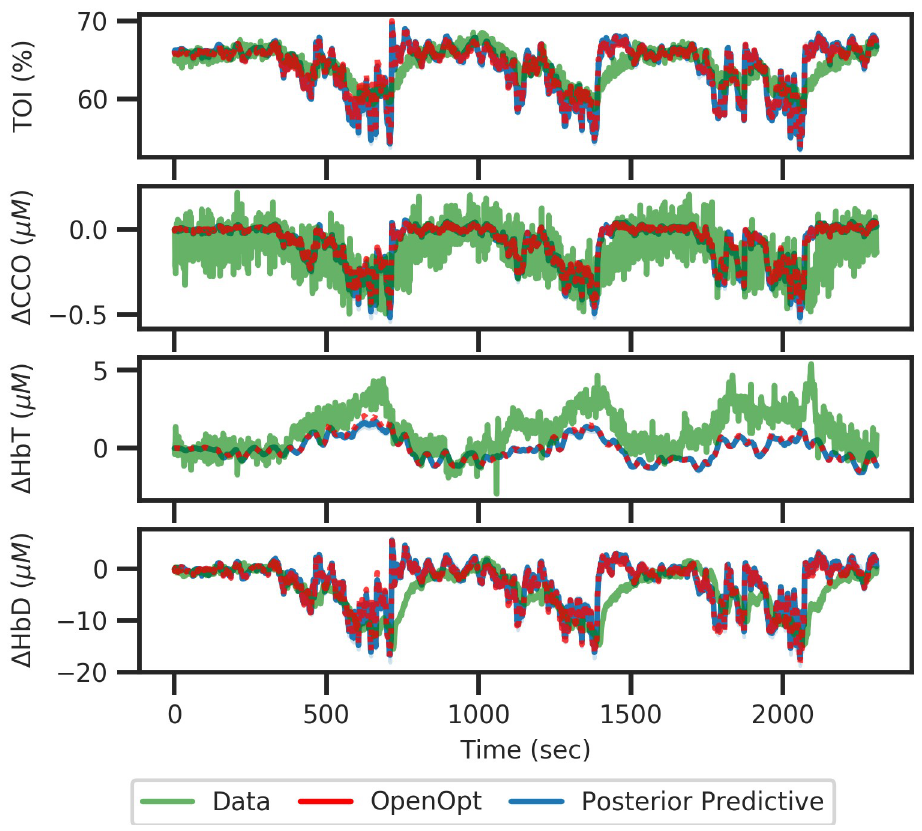
Fig 12. Predicted fits for the experimental data set. Fig 12 shows the predicted time series for all output based on the posterior shown in Fig 11. The posterior was sampled 25 times with the resulting time series aggregated, with the median and 95% credible intervals plotted in dark and light blue respectively. Overall behaviour is reflected in the predicted trace, with 3 distinct periods of hypoxia visible as periodic behaviour within all signals. The fit obtained using OpenOpt is shown in